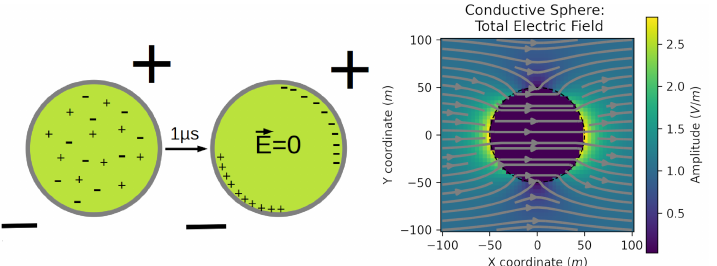
Figure 3. Schematic representation of the movement of charges inside a simplified model of a cell containing positive and negative charges under the application of an external electric field. After a suitable elapsed time, for instance 1 µ s, the movement of charges reaches an equilibrium, resulting in the electric field inside the cell being nullified. Right panel showing the total electric field extracted from https://em.geosci.xyz (accessed on 27 April